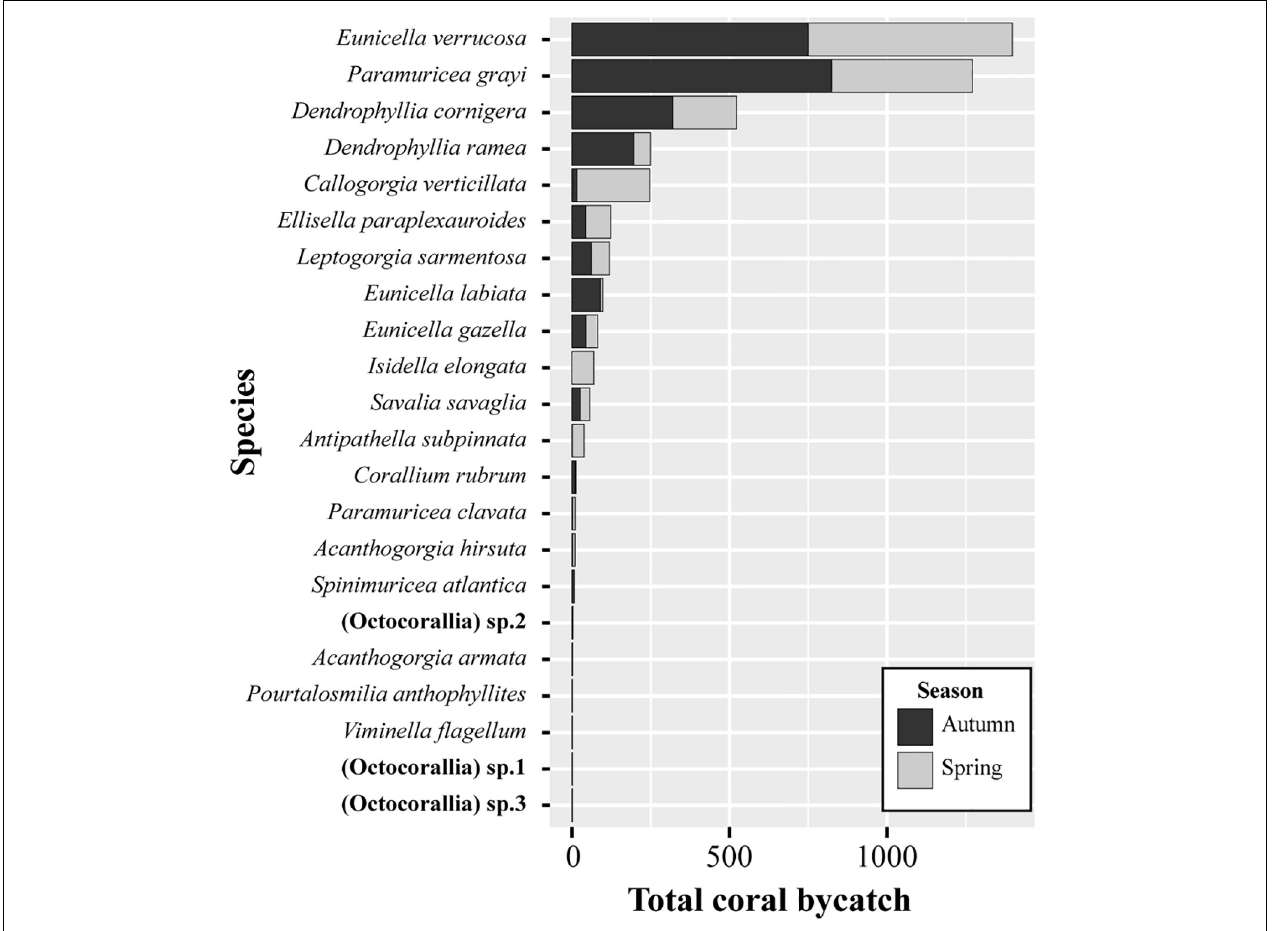
FIGURE 2 | Species composition and total amount of the corals caught as bycatch in bottom-set gillnets during the two sampling seasons in Sagres (southern Portugal). In total, 4326 specimens (branch fragments or entire colonies) were collected from 118 gillnet deployments.